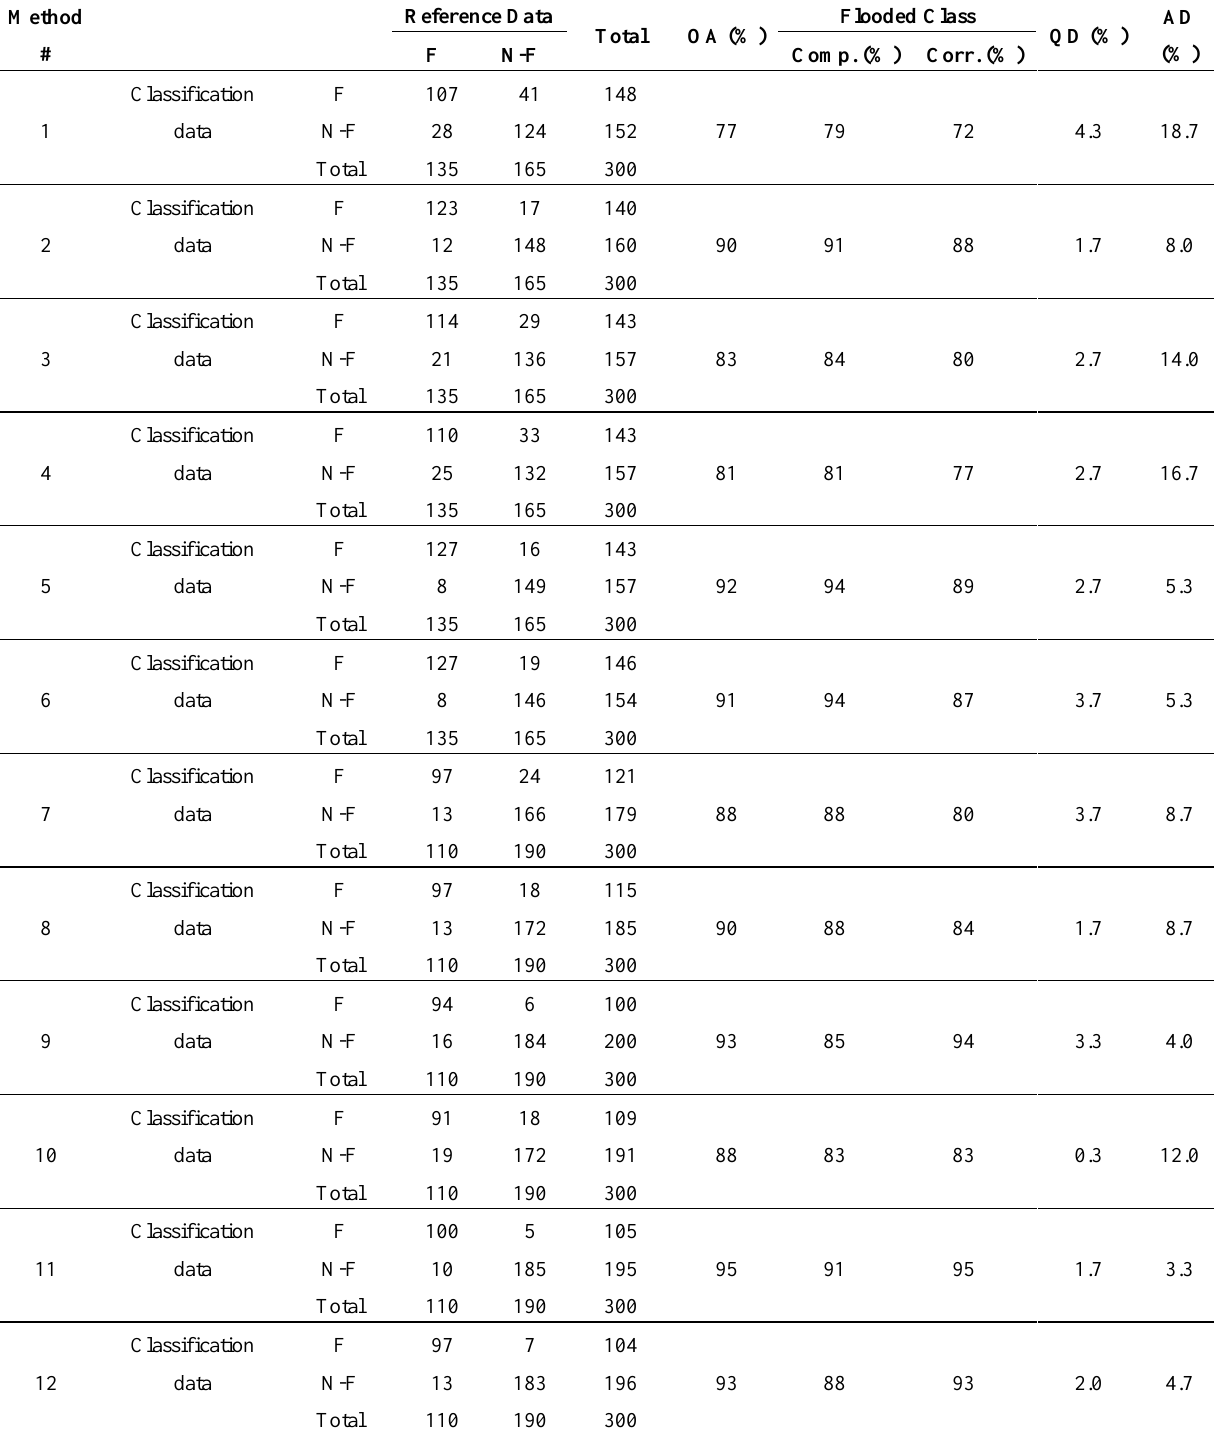
Table 4 . Error matrices and the accuracy assessment measures derived for the classification methods used in this